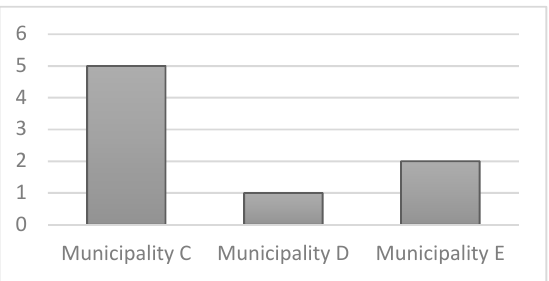
Figure 3. Degree of knowledge about the risk management strategies in Municipalities C, D and E.